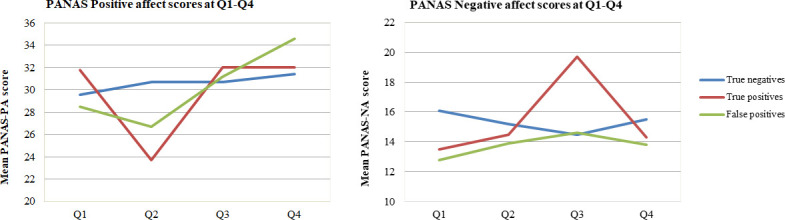
Individual well-being measured by mean PANAS-positive affect and PANAS-negative affect scores in the study period for all women.A higher PA score indicates a more favorable score. A higher NA score indicates a less favorable score.